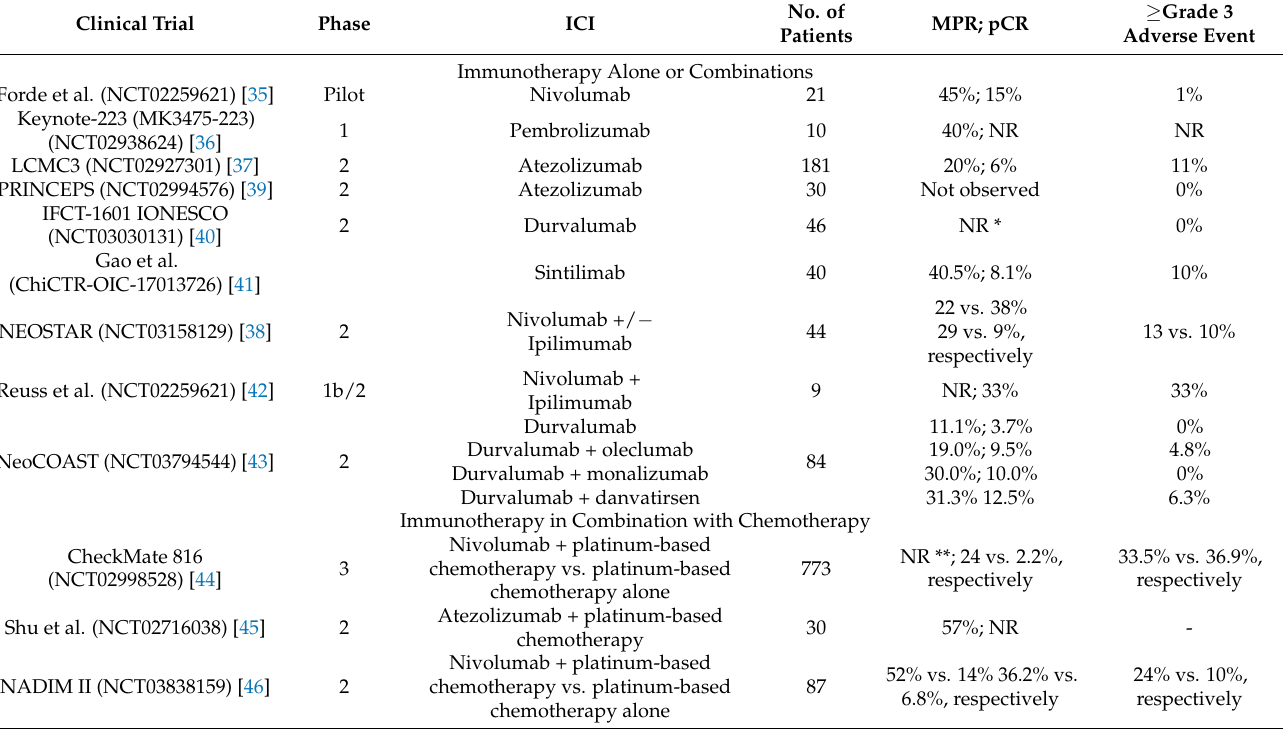
Table 1. Most-relevant Published Clinical Trials of Neoadjuvant ICIs +/ − Chemotherapy in Re- sectable